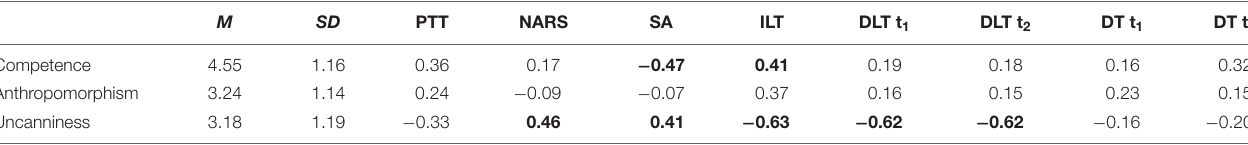
FIGURE 3 | Study procedure of the laboratory study and times of measurement including the two layers of learned trust. TABLE 1 | Descriptives of a priori robot evaluations and bivariate correlations with user dispositions, state anxiety and trust layers at the different times of